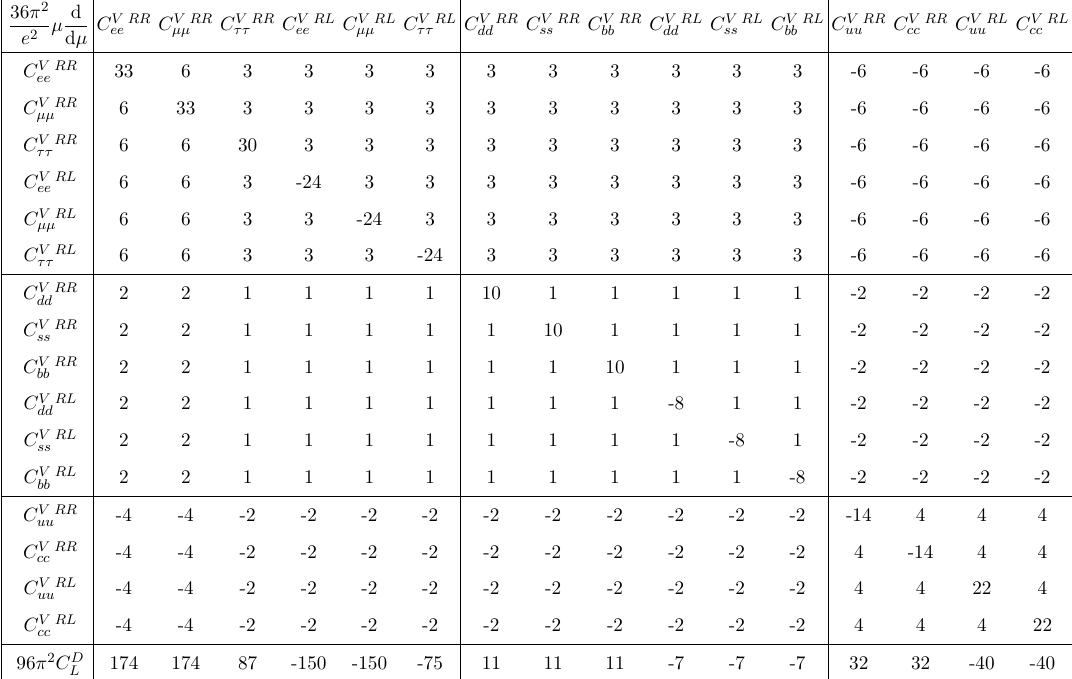
Table 2. Entries of the transposed anomalous dimension matrices (cid:0) V (upper squared block) and (cid:0) V D (last row) for the vector operators. The last row determines the two-loop mixing of the vector operators into the dipole